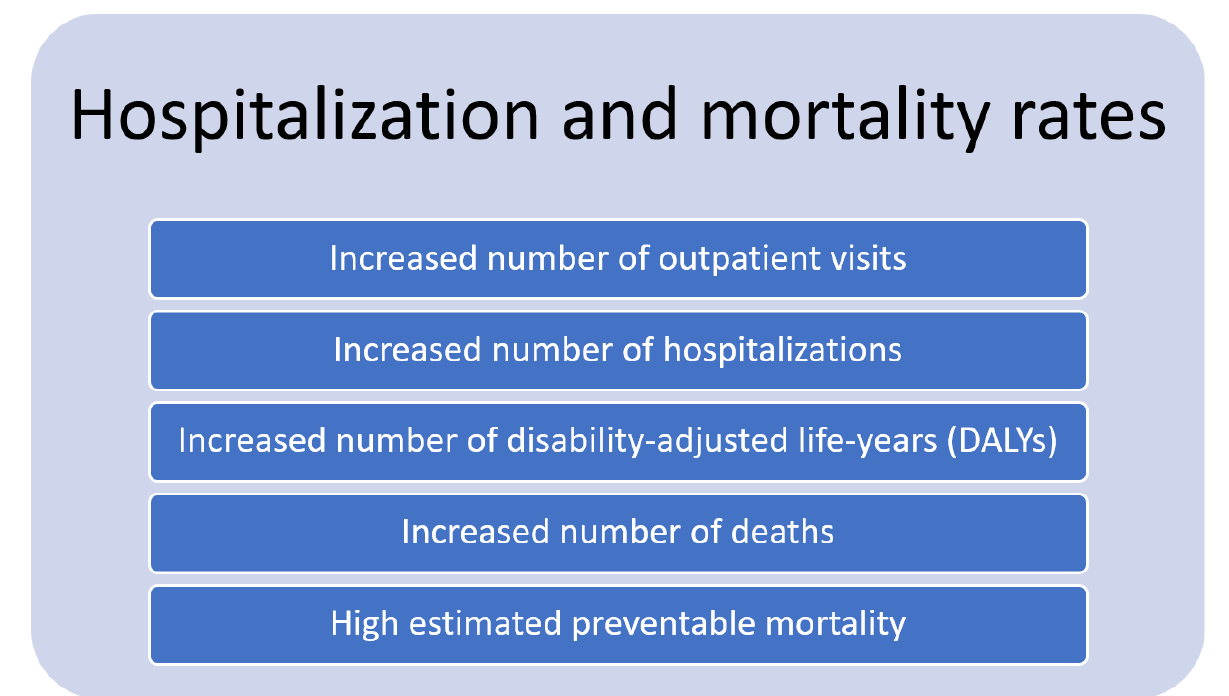
Figure 4. Effect of air pollution on hospitalization and mortality rates.